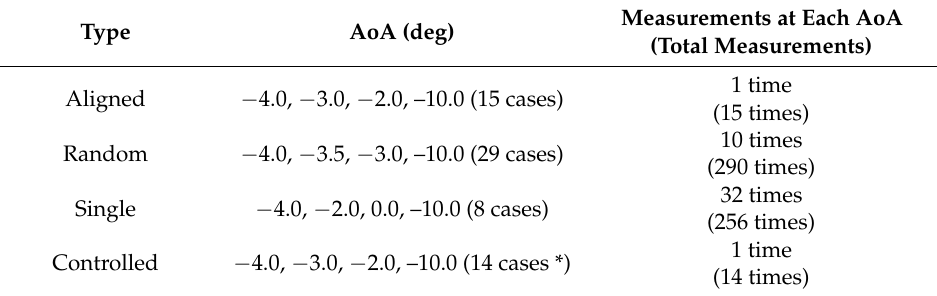
Table 3. Test cases.